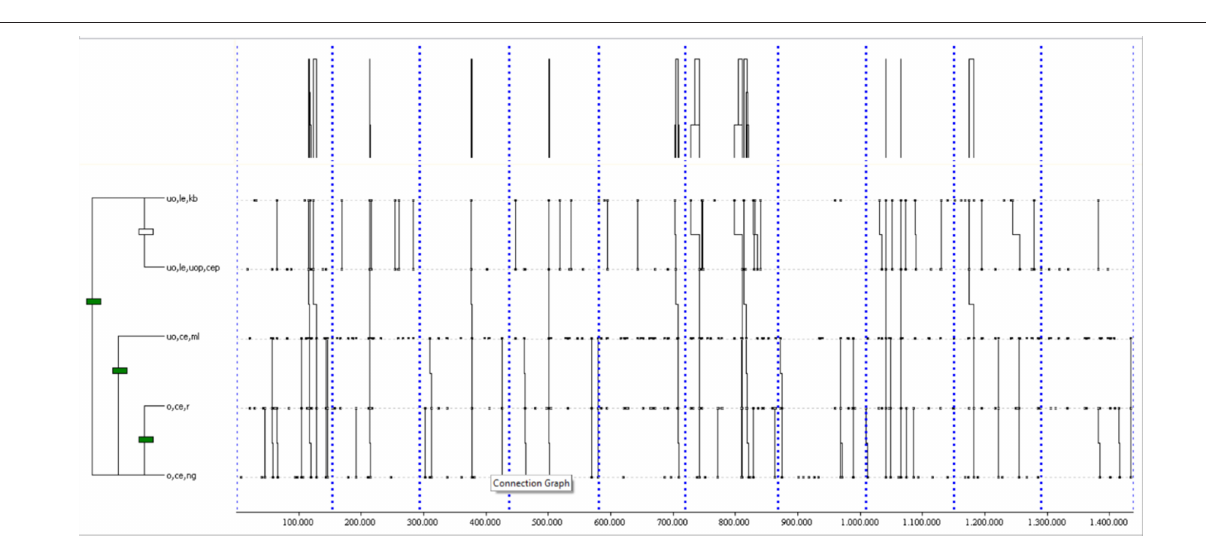
FIGURE 5 | One of the most complex T-patterns from home matches with a NoGoal. It occurred in 80% of the games analyzed. Events are (1) uo,le,kb; (2) uo,le,uop,cep; (3) uo,ce,ml; (4) o,ce,r; and (5)